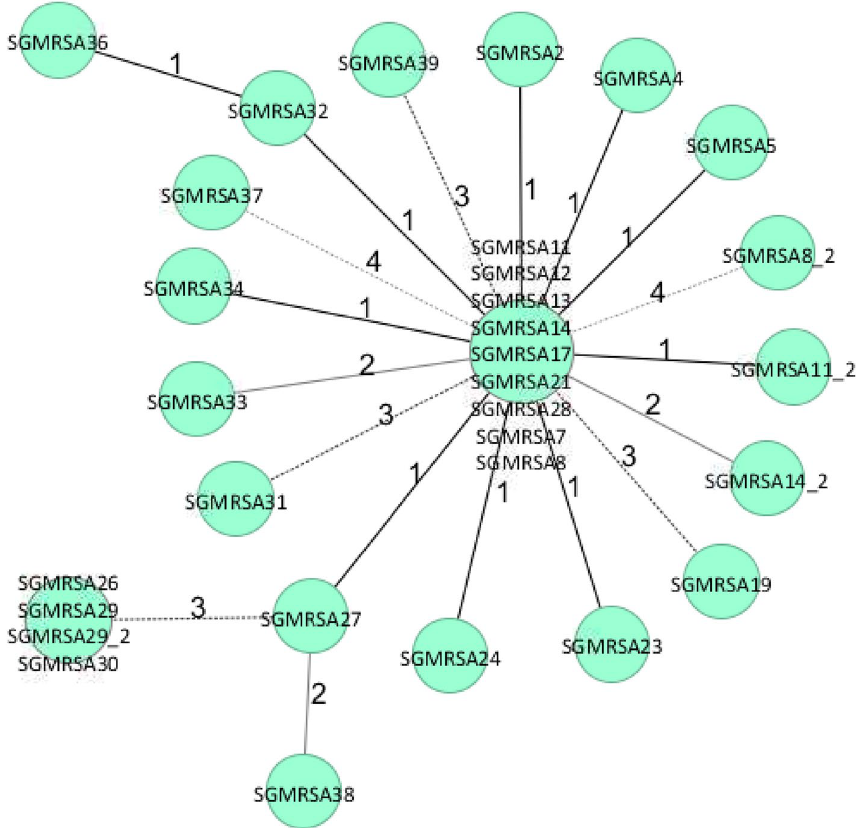
Figure 3. Phylogenetic single nucleotide polymorphisms (SNP) tree of the core cluster (N = 31).